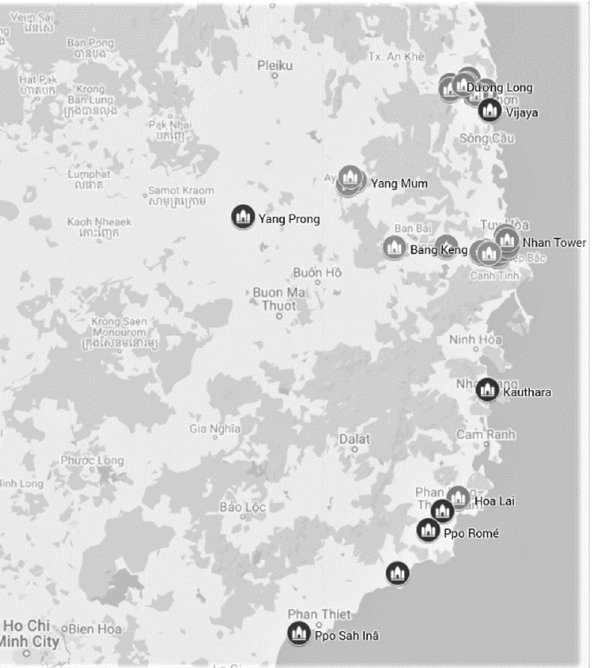
Figure 3. Champ ā Archaeological Sites: Vijaya, Kau ṭ h ā ra, and P ā ṇḍ ura ṅ ga (Designed in Google Figure 3. Champ¯a Archaeological Sites: Vijaya, Kaut.h¯ara, and P¯an.d. ura˙nga (Designed in Google Maps by Noseworthy). Maps by